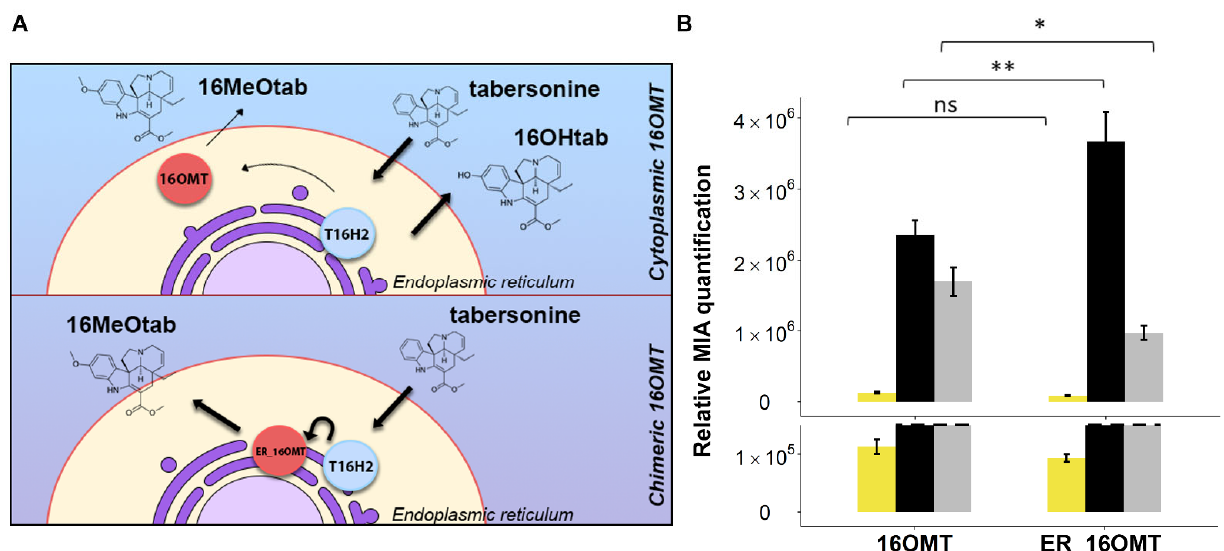
Figure 5. Localization approach for metabolic channeling. ( A ): Schematic illustration of ER ‐ anchored 16OMT (ER_16OMT) construction and its hypothetical metabolic channeling. ( B ): The effect of anchoring 16OMT to ER was evaluated by feeding yeasts (16OMT strain: episomal expression of 2xT16H2 and native 16OMT; ER_16OMT strain: episomal expression of 2xT16H2 and ER_16OMT) with tabersonine. Alkaloids were quantified by UPLC ‐ MS in the yeast culture medium 24 h post ‐ feeding with tabersonine (250 μ M). The dashed line represents the scale cut for the visualization of accumulated intermediates of low volume. Statistical analyses were performed with a two ‐ tailed t ‐ test ( p <= 0.1, *: p <= 0.05, **: p <= 0.01, ns: not significant). Light yellow = tabersonine, black = 16 ‐ hydroxytabersonine, grey = 16 ‐ methoxytabersonine. Error bars correspond to the standard error of biological replicates ( n = 3). MIA composition of the yeast culture medium is expressed as relative peak areas.